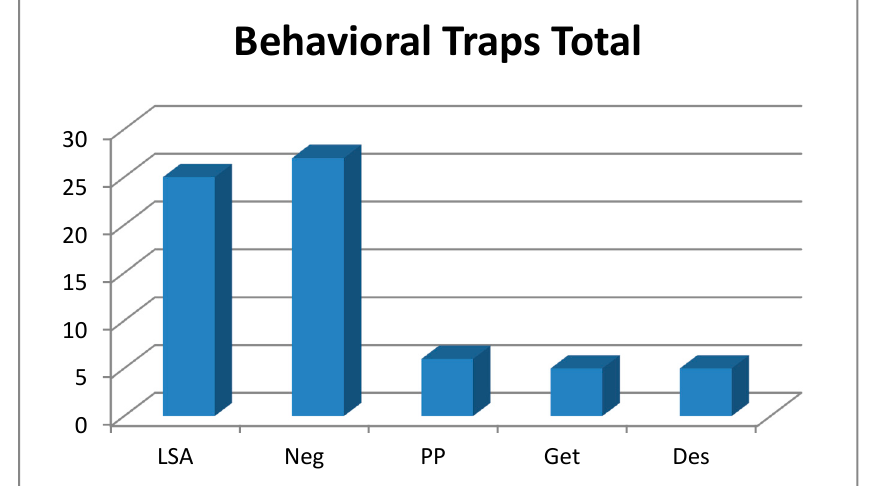
Figure 1. Frequency count of all behavioral traps found. LSA = Loss of Situational Awareness, Neg = Neglect of Flight Planning, Preflight Inspections, and Checklists, PP = Peer Pressure, Get = Get-There-Itis, Des = Unauthorized Descent Below an IFR Altitude.